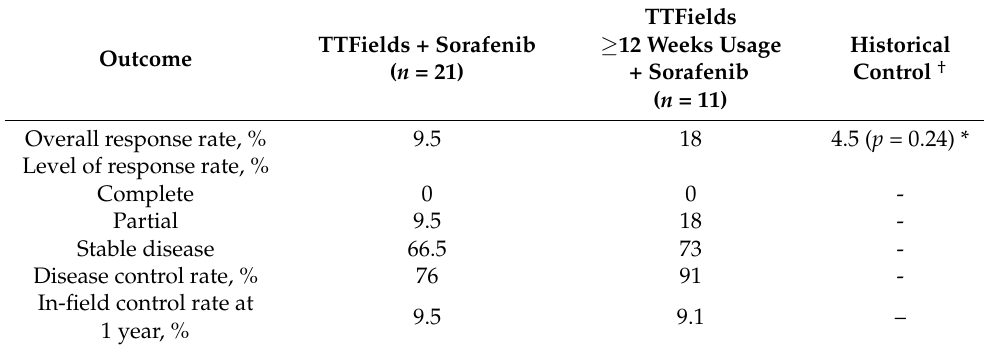
TTFields + Sorafenib ( n = 21)